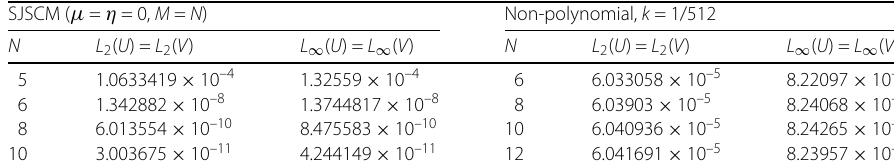
Table 20 L 2 and L ∞ error norms for u ( x , t ) = v ( x , t ) of Example 3 when 0 ≤ x ≤ 1, α 1 = α 2 = 0.6 SJSCM ( μ = η = 0, M = N ) Non-polynomial, k = 1/512